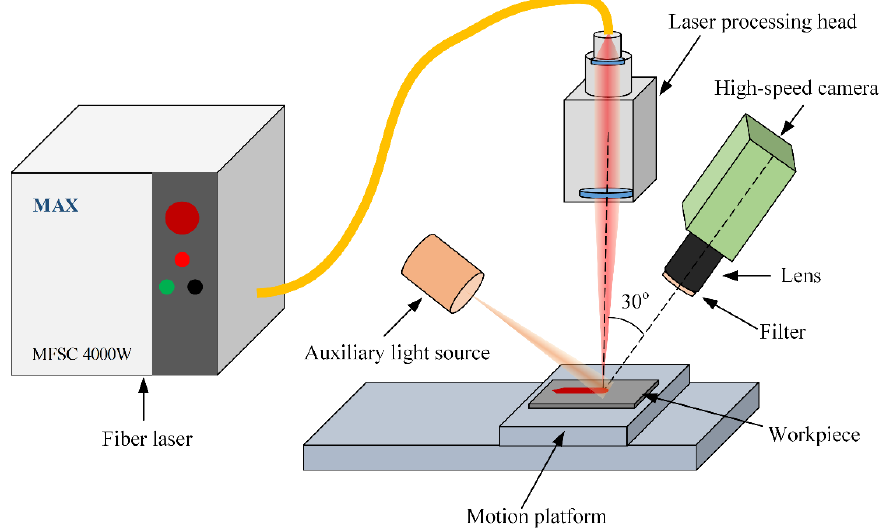
Figure 5. Experimental configuration.